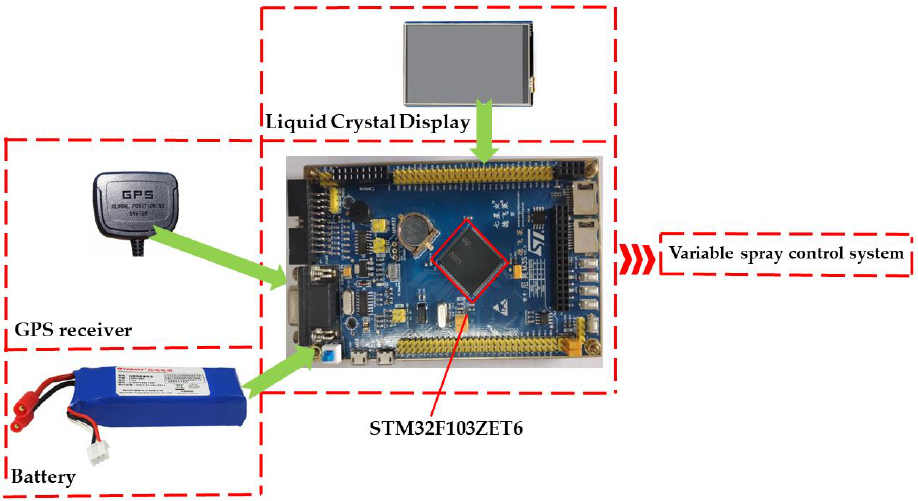
Figure 5. Schematic diagram of hardware representing a prescription graphic translation Figure 5. S chematic diagram of hardware representing a prescription graphic translation system.